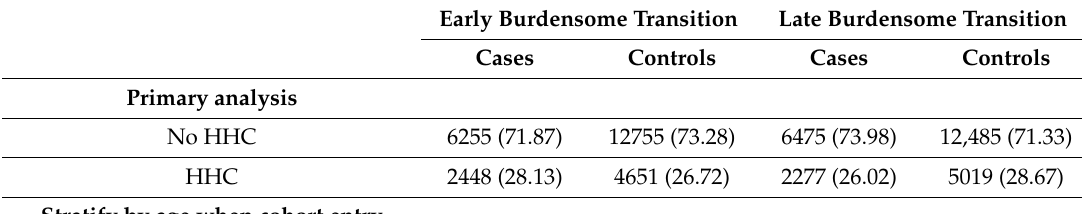
Figure A1. Illustration of people with dementia in different groups with or without burdensome end-of-life transition. * In the regression model, the early burdensome transition represents those with early transition only and those with both early and late transition; the late burdensome transition represents those with late transition only. TableA3. Numbersofcaseswithburdensometransitionsattheend-of-lieandthecontrolsinpeoplewith dementia who received home healthcare compared with those who had no home healthcare